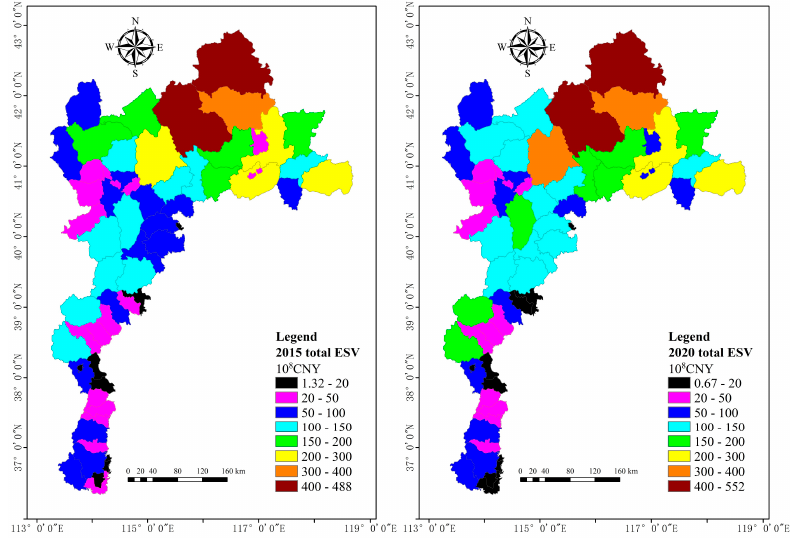
Figure 6. Total ESV of study area at county scale in 2015 and 2020.